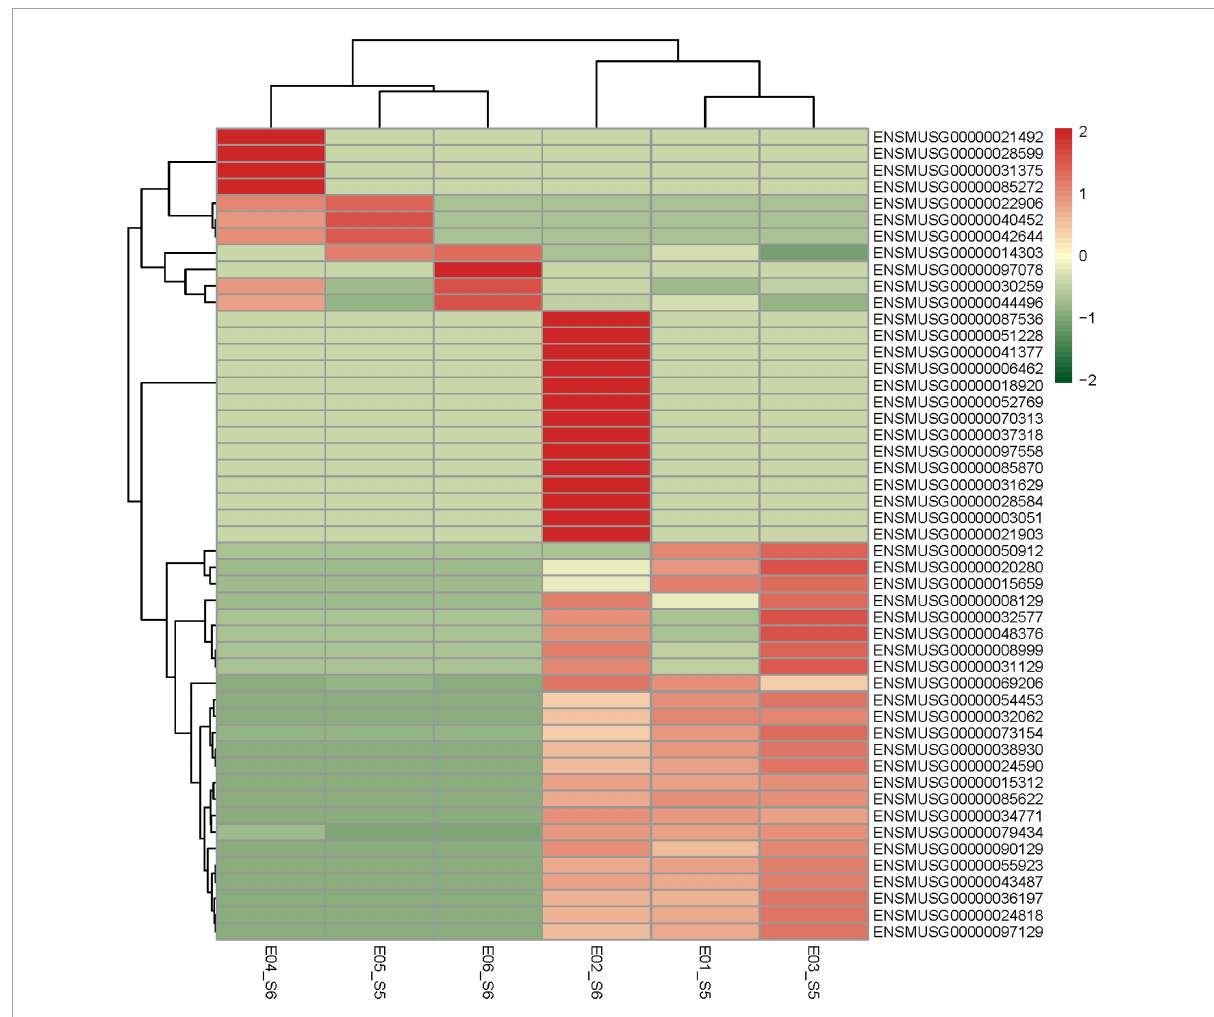
FIGURE2 Heatmap of DEGs. Red areas represent highly expressed genes and green areas represent lowly expressed genes. DEGs, differentially expressed